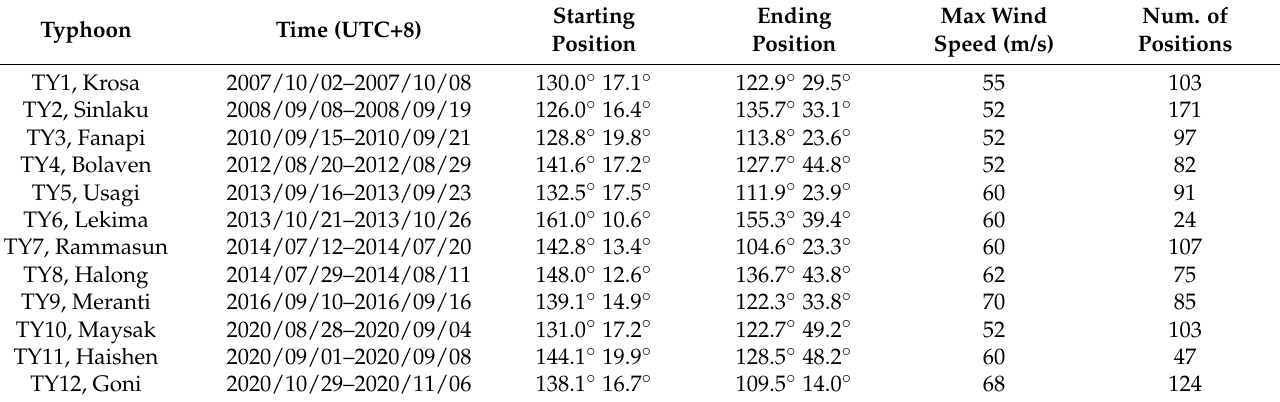
Figure 2. Tracks of the twelve typhoons shown in Table 2. The color bar indicates the wind speed (m/s). Table 2. Brief information of the twelve typhoons selected in this